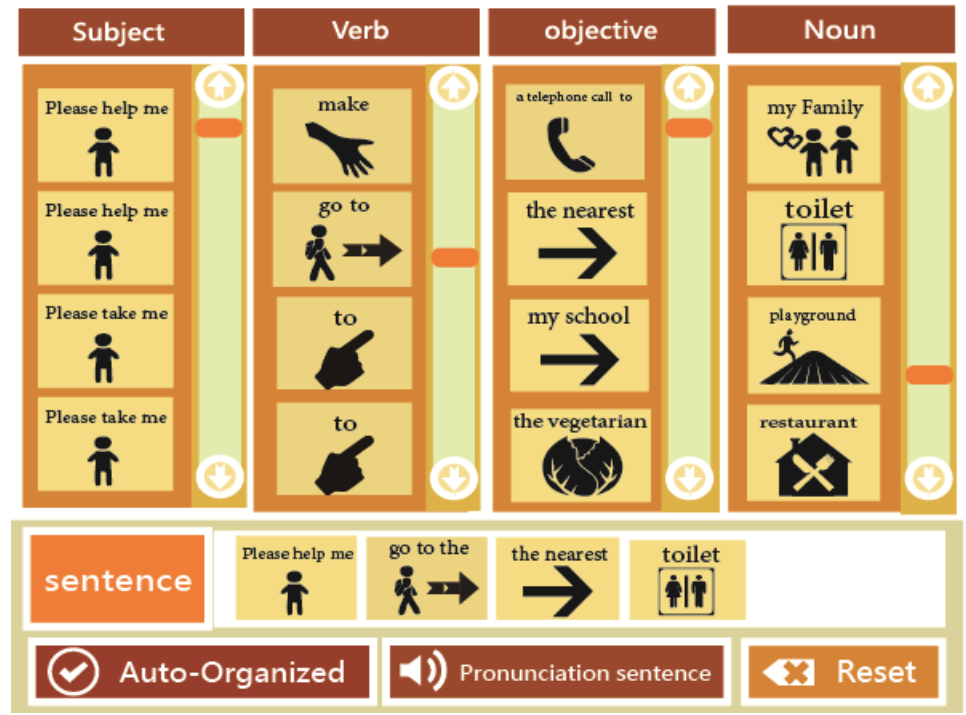
Figure 1. Using the Auto Organizational Menu to request help.